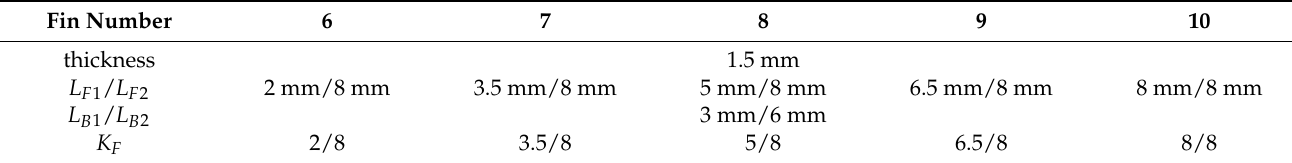
Table 2. Details of leading-edge flexibility